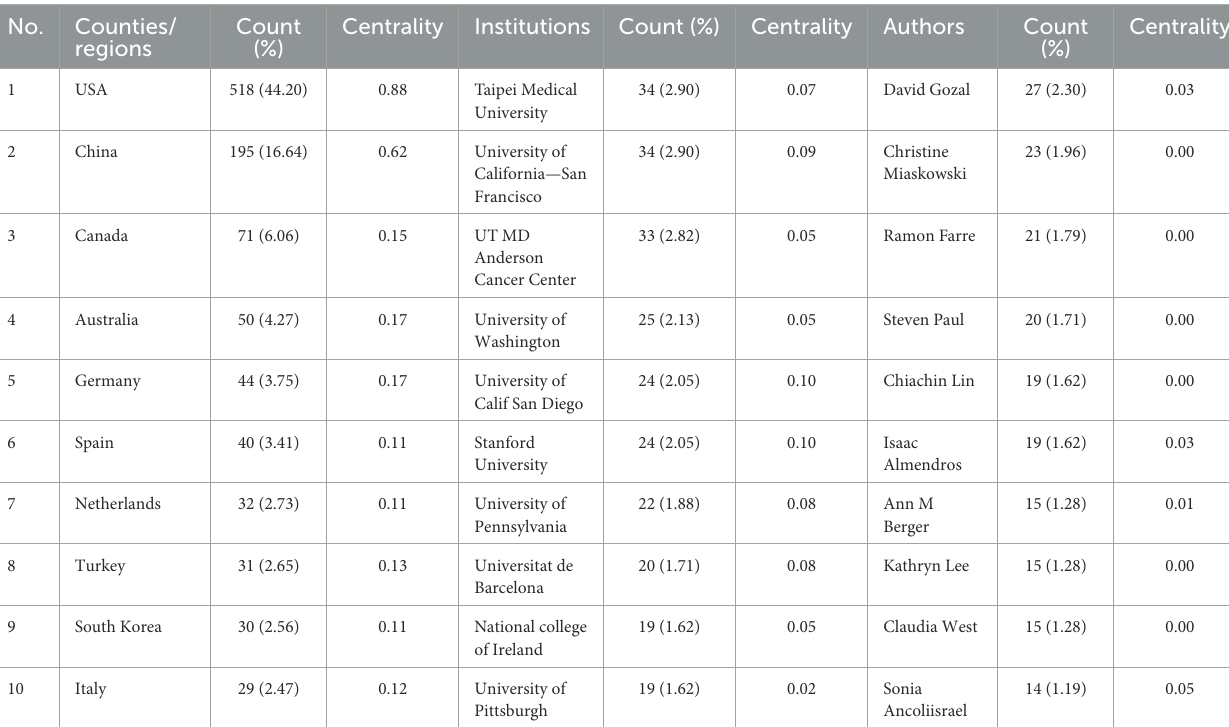
TABLE 2 Top 10 countries, institutions, and authors in cancer and sleep research.